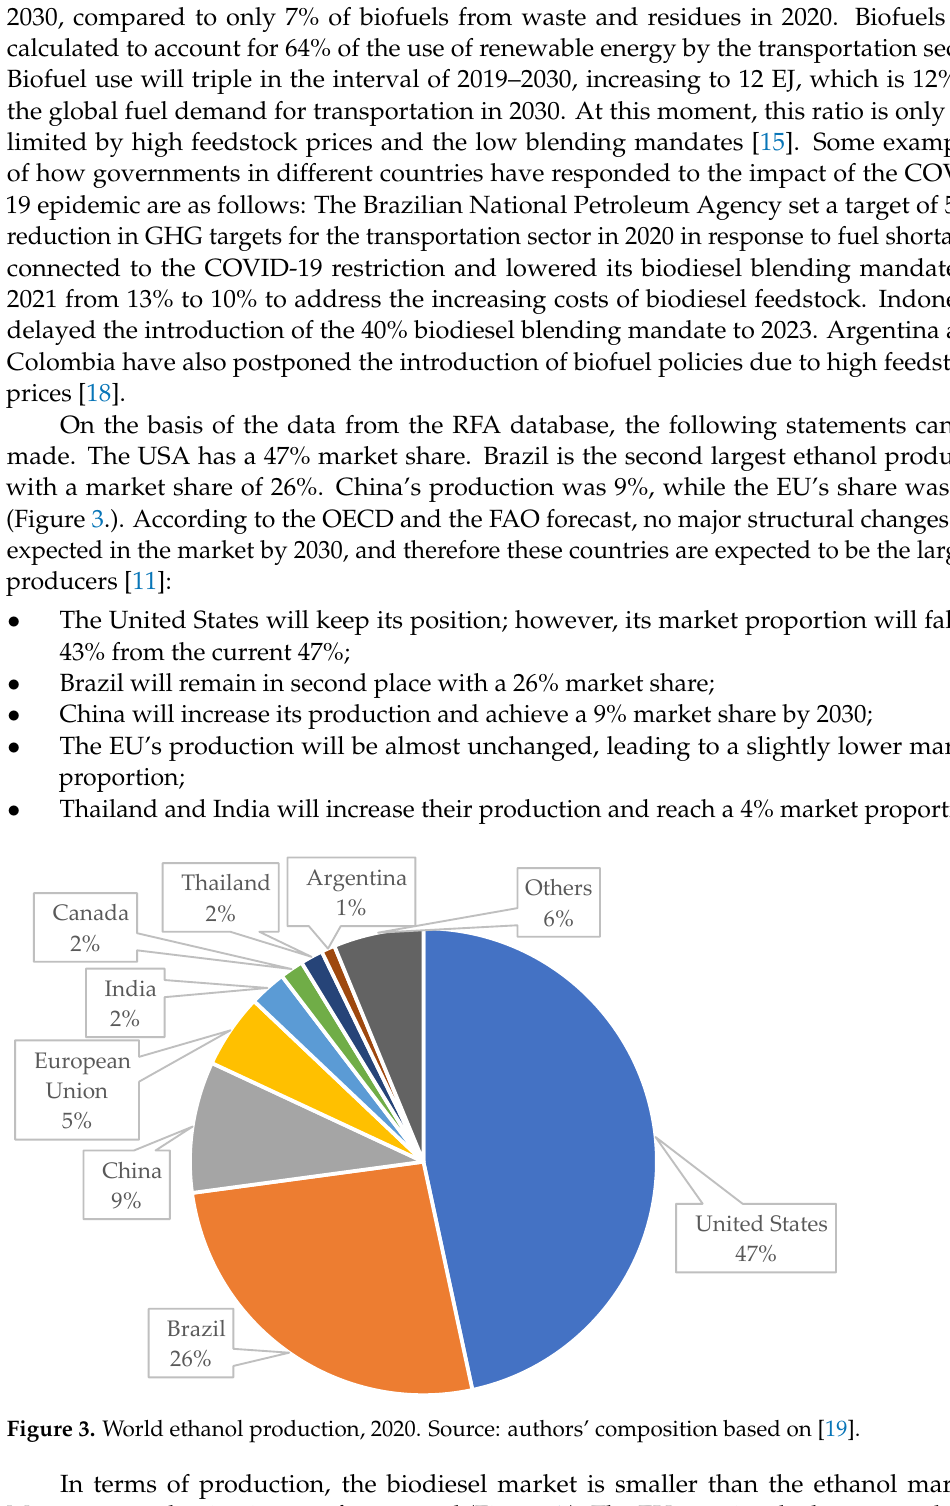
Figure 4. World biodiesel production, 2020. Source: authors ’ composition based on [11]. The OECD and FAO forecast a change in the ranking of the largest producers for the next 10 years. The data show that the EU will remain the largest producer, but its market share will decrease slightly to 28% by 2030. The other projections are as follows [11]: 1.